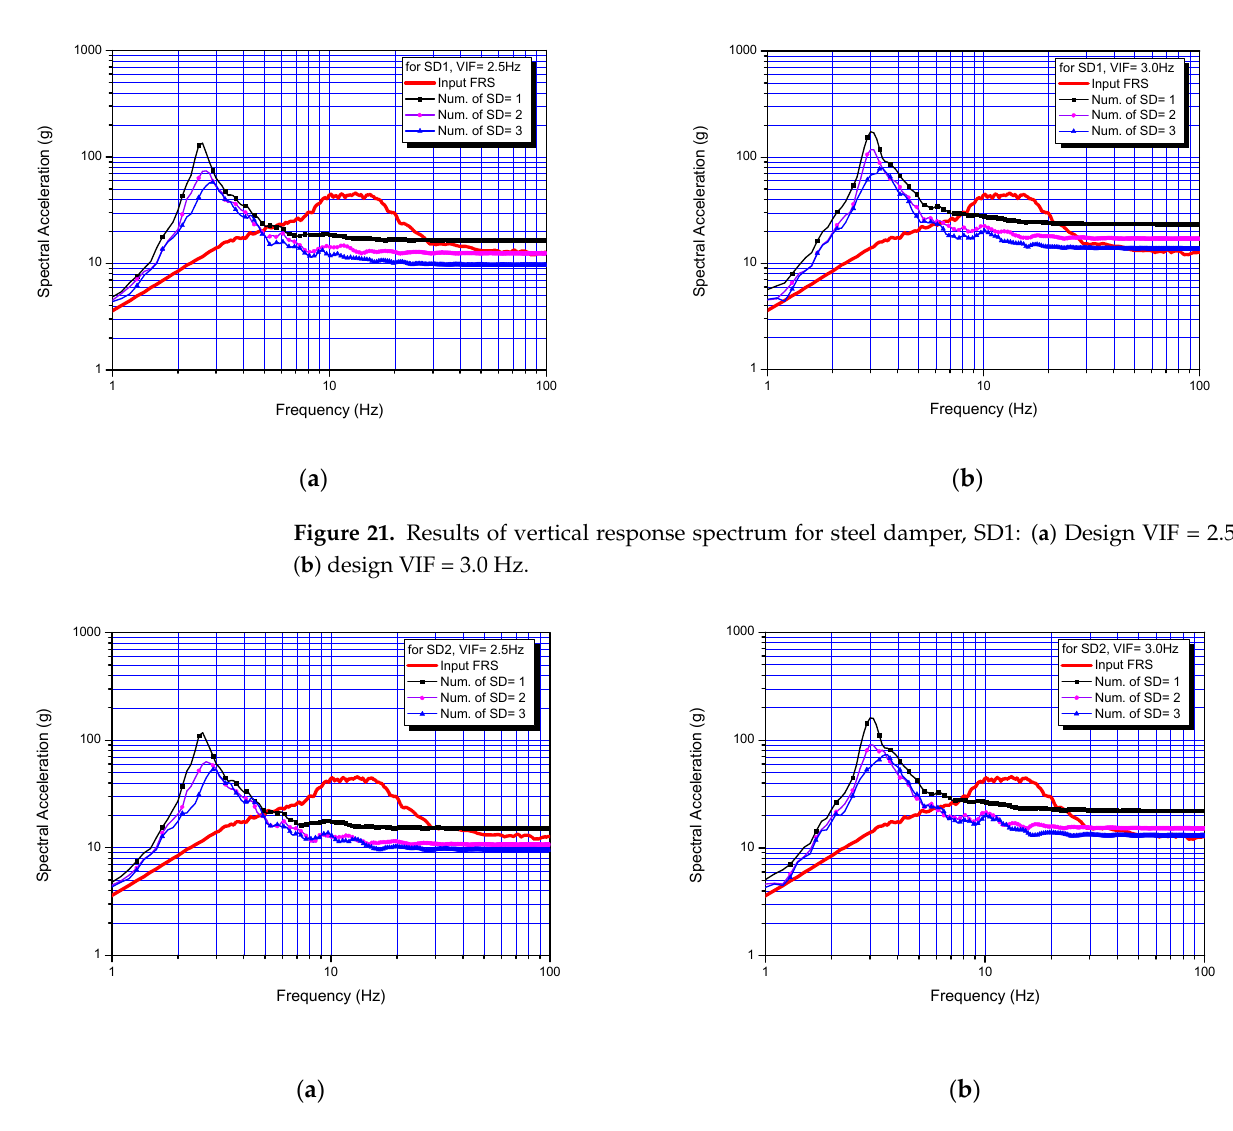
Figure 22. Results of vertical response spectrum for steel damper, SD2: ( a ) Design VIF = 2.5 Hz; ( b ) design VIF = 3.0 Hz.